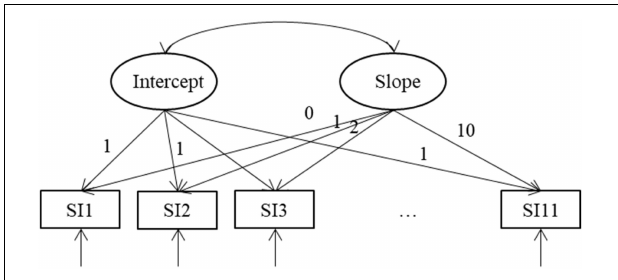
FIGURE 1 | Growth mixture model (GMM) for suicidal ideation (SI).